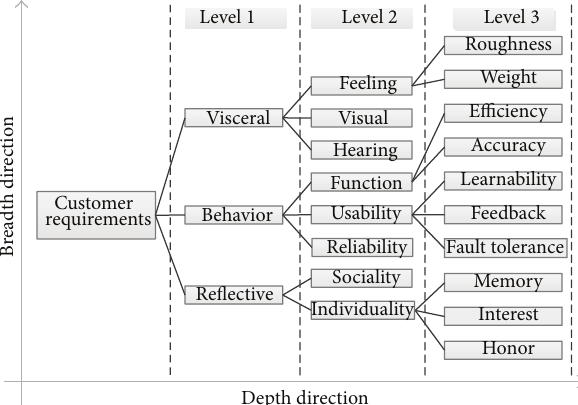
Figure 2: Topology structure of customer